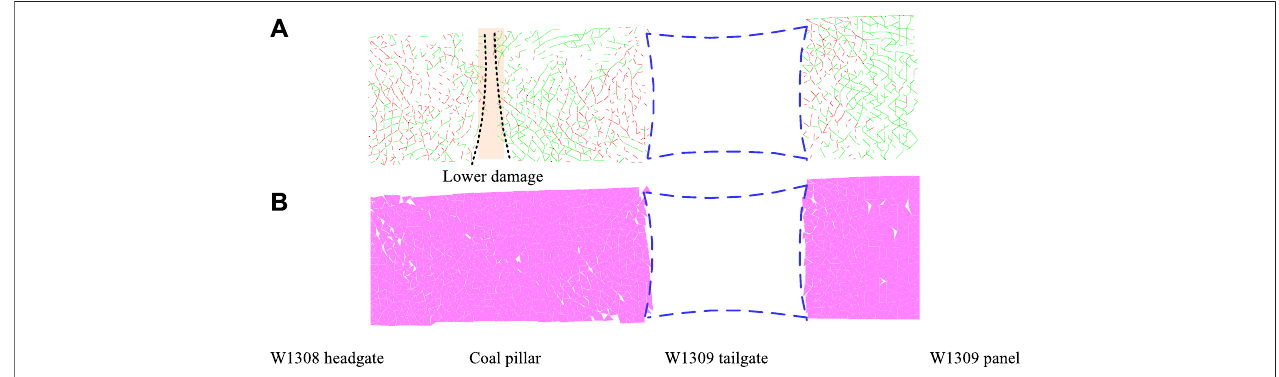
FIGURE 11 | The failure rule of coal pillar and W1309 tailgate during repeated mining disturbance after reinforced support. (A) Crack features in coal pillar; (B) Failure model of coal pillar and roadways.